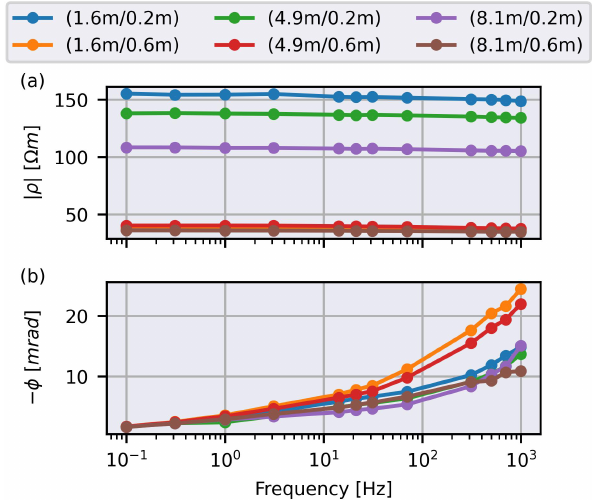
Figure 14. Intrinsic spectra extracted from tomographic analyses of all frequencies (August 2018). Labels denote the ( x/z ) position in the tomogram where the spectra were extracted. The spectra repre- sent the median values of all inversions in a 24h interval around the target time considering all inversion results with rms values between 0.95 and